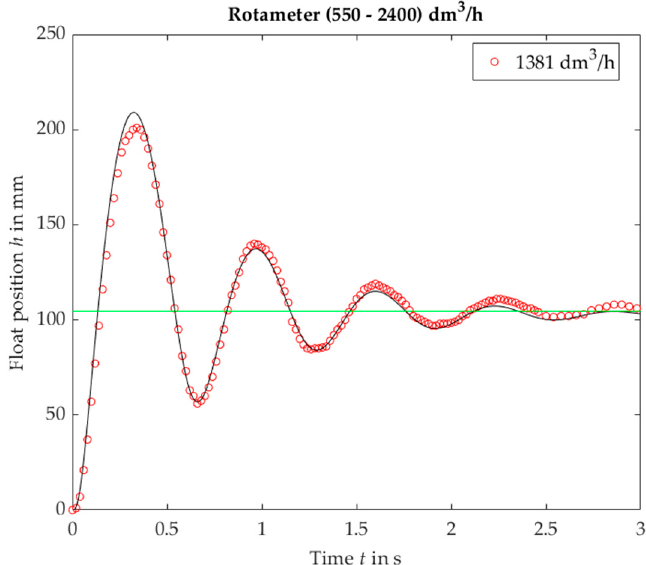
Figure 9. Rotameter no. 7, sphere shape. Float position h vs. time t for a step response, experimental (black solid lines) and calculated (markers).